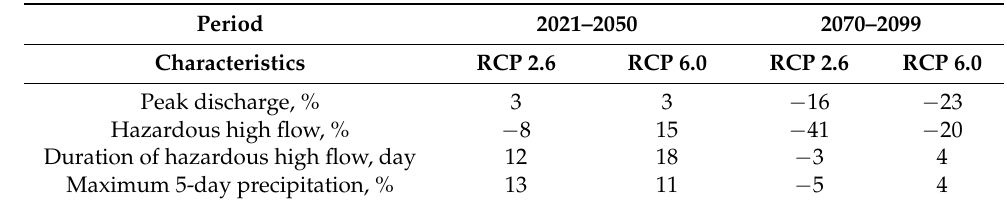
Table 8. Anomalies of the seasonal peak discharge, hazardous high flow and its duration, as well as the maximum 5-day precipitation over the summer in the Iya River basin for the period 2021–2050 and the end of the 21st century (2070–2099), relative to 1990–2019. Period